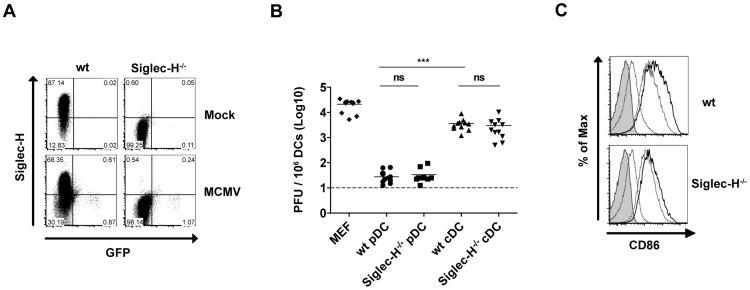
Siglec-H receptor does not play a role in pDC infection.Flt3-L derived CD11c+ B220+ pDCs and CD11c+ B220− cDCs were sorted from BMDC cultures of wt and Siglec-H−/− mice. DCs were mock treated with PBS or MCMV-GFP infected at MOI 2. (A) Representative FACS plots show Siglec-H expression and MCMV-GFP expression at 24 h p.i. (B) Quantification of the viral titers per 106 DCs or MEFs at 24 h p.i. (C) Representative histogram plots of CD86 expression on wt and Siglec-H−/− sorted pDCs (live cell gate) at 24 h p.i. (gray bar = isotype control, gray dashed line = mock treatment, gray solid line = CpG-A treatment, dark bold line = MCMV infection). Data are from one of three individual experiments with similar results. ns = not significant ***p<0.001, Students t-test.